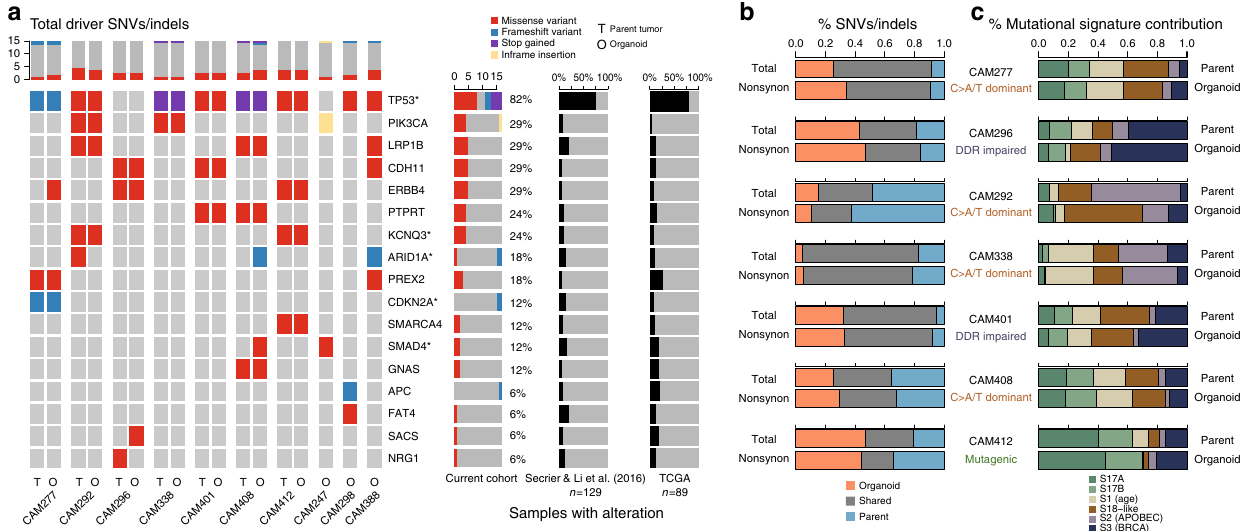
Fig. 2 Concordance of driver somatic events, SNV/InDels, and mutational signatures between tumor and matched organoid cultures. a Cancer driver genes affected by nonsynonymous SNVs and InDels are highlighted in the derived organoid culture (O) and corresponding patient-matched tumors (T) where available. Only cancer genes that were also found mutated in at least 5% of the patient cohort ( n = 129) in the study by Secrier & Li et al. 13 are displayed, with signi fi cantly mutated genes by MutSigCV quoted in the study marked with an asterisk (*). Prevalence of alterations from the analysis of large cohorts of patient tumors (Secrier & Li et al. paper and TCGA ( n = 89)) are shown on the right. The variant allele frequencies for each mutation are provided. b Proportion of shared and unique mutations between patient-matched tumor and organoid culture. c Concordance of mutational signature